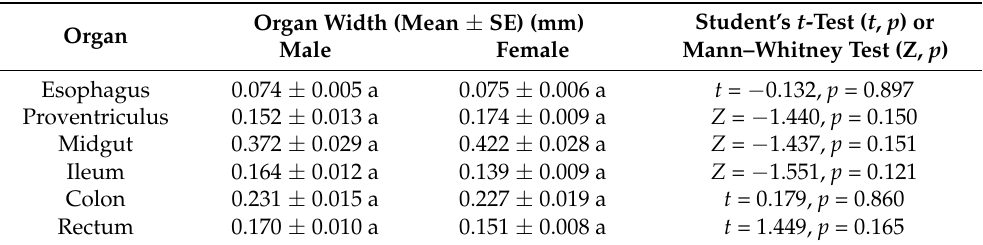
Table 1. The width (mm) (mean ± SE) of different organs in the alimentary canal of male and female M . ( O .) chinensis